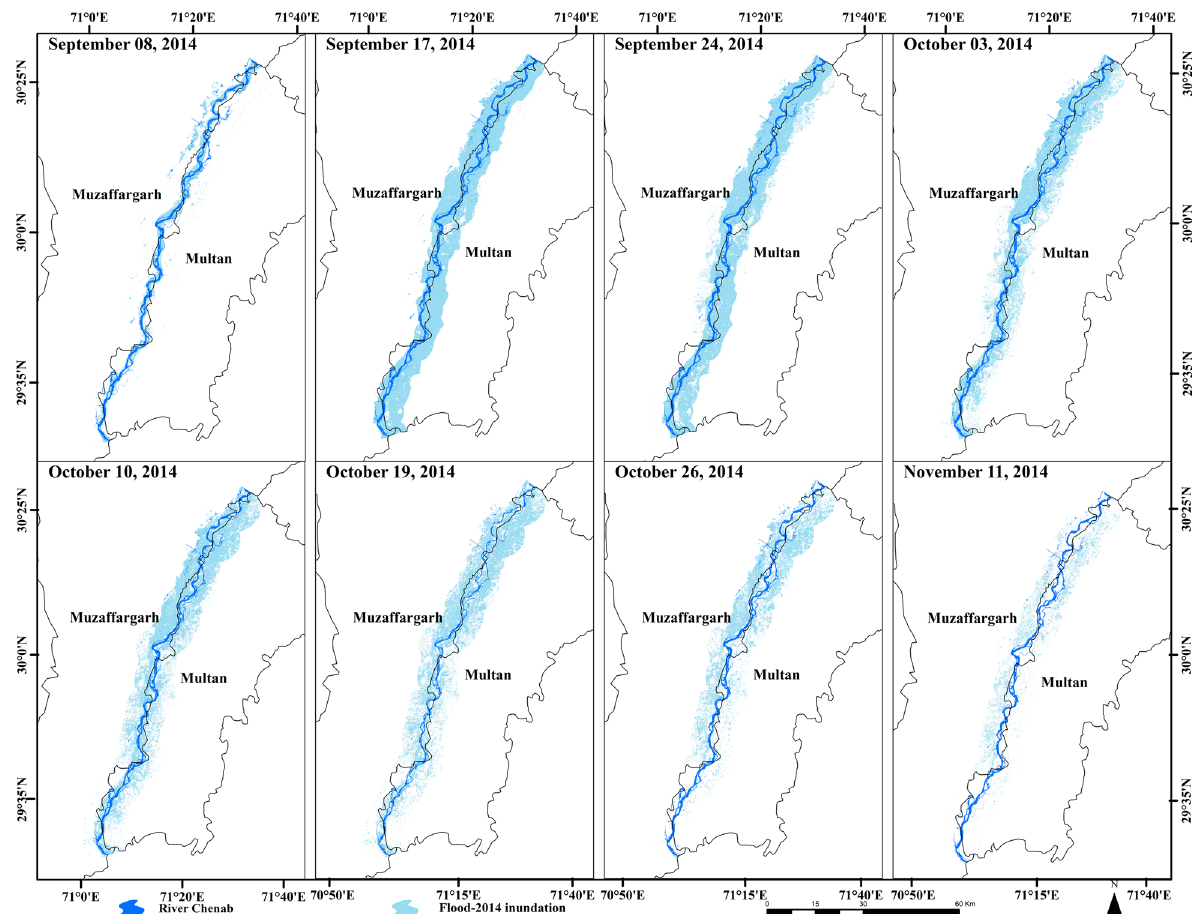
Fig. 3 Spatio-temporal flooded areas extent from pre-flood to post-flood using MNDWI